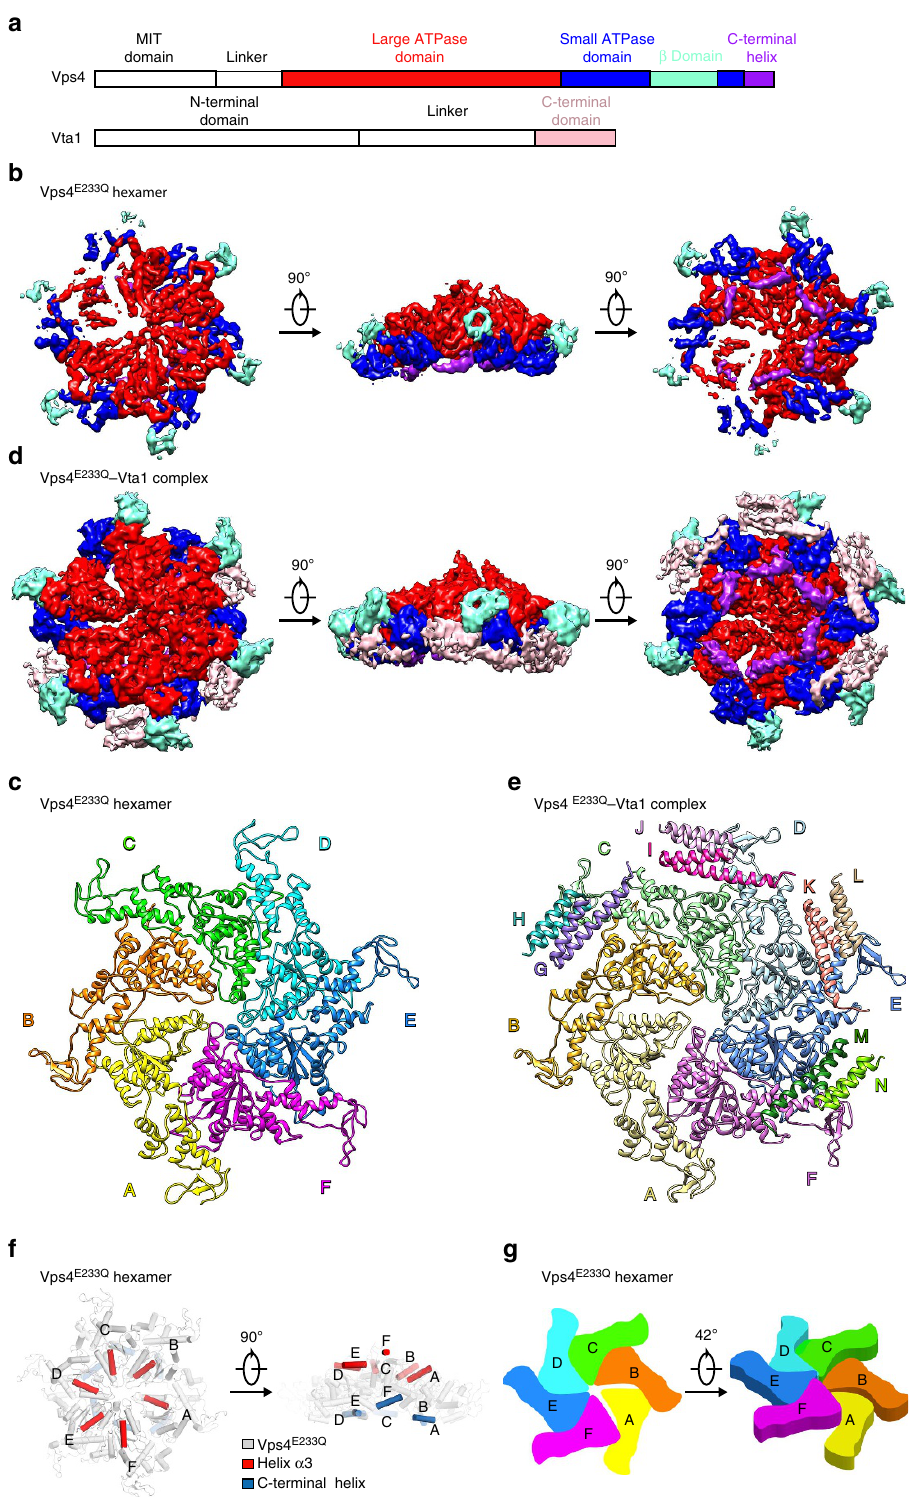
Figure 1 | Overall structures of the ATP-bound Vps4 E233Q hexamer and its complex with Vta1. ( a ) Domain diagrams of the yeast Vps4 (upper) and Vta1 (lower). ( b ) Different views of the EM density map of the ATP-bound Vps4 E233Q hexamer at 5.8 s contour level. ( c ) The atomic model of the Vps4 E233Q hexamer. Vps4 E233Q subunits are colour coded. ( d ) Different views of the EM density map of the ATP-bound Vps4 E233Q –Vta1 complex at the 3.9 s contour level showing the positions of the Vta1. ( e ) The atomic model of the ATP-bound Vps4 E233Q –ta1 complex. Vps4 E233Q subunits and Vta1 subunits are colour coded. ( f ) Different views of the helix a 3 and C-terminal helix in the Vps4 E233Q hexamer to show the spiral arrangement of Vps4 subunits. ( g ) A schematic diagram showing the topology of the Vps4 E233Q subunits in the Vps4 E233Q hexamer. The colouring scheme is the same as in ( c